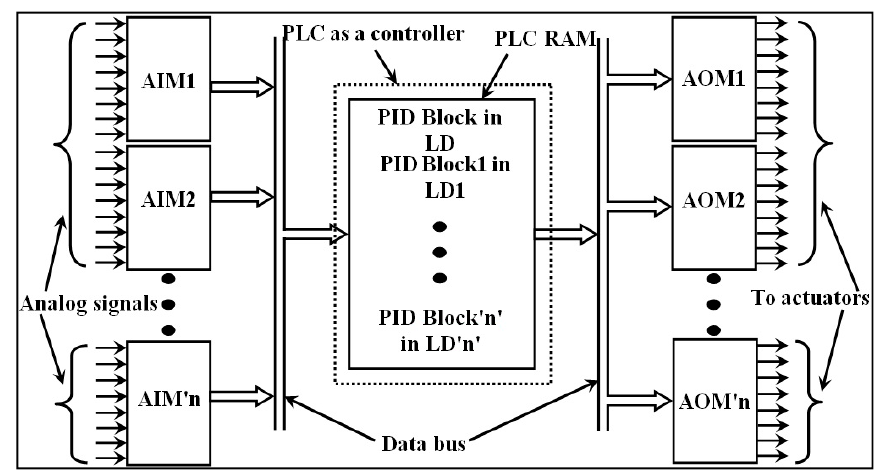
Figure 1. Organization of closed-loop control system using a PLC.